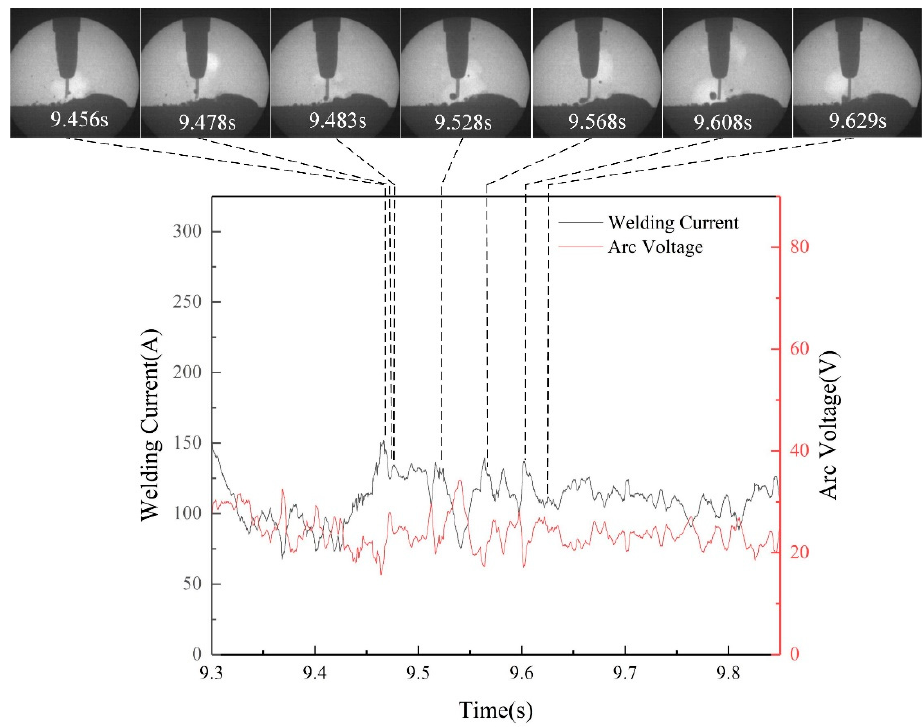
Figure 6. Typical globular repelled transfer mode and electric signal (28% filling rate).